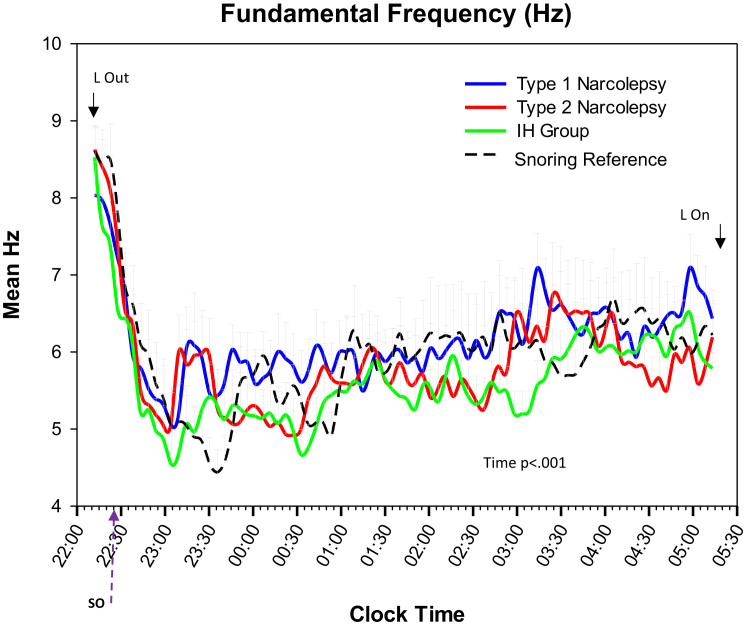
Fundamental Frequency (Hz) Across time. Fundamental frequency = mean EEG cycles per second (Hz). Each vertical tick on the X-axis represents a 5-min time bin of the PSG (PSG = the first 7 h from Lights out; mean of 22:12 +/− 32 min). SO = mean sleep onset for all groups (no statistical differences between groups). Trend lines represent spline-smoothed changes in mean fundamental frequency over time. Bars represent standard error bars (SEM). Mixed model ANOVA with Bonferroni post-hoc comparisons was used to assess group (N = 4) by time (N = 82 time increments) changes. Main effect of time present with no interaction or group effects.